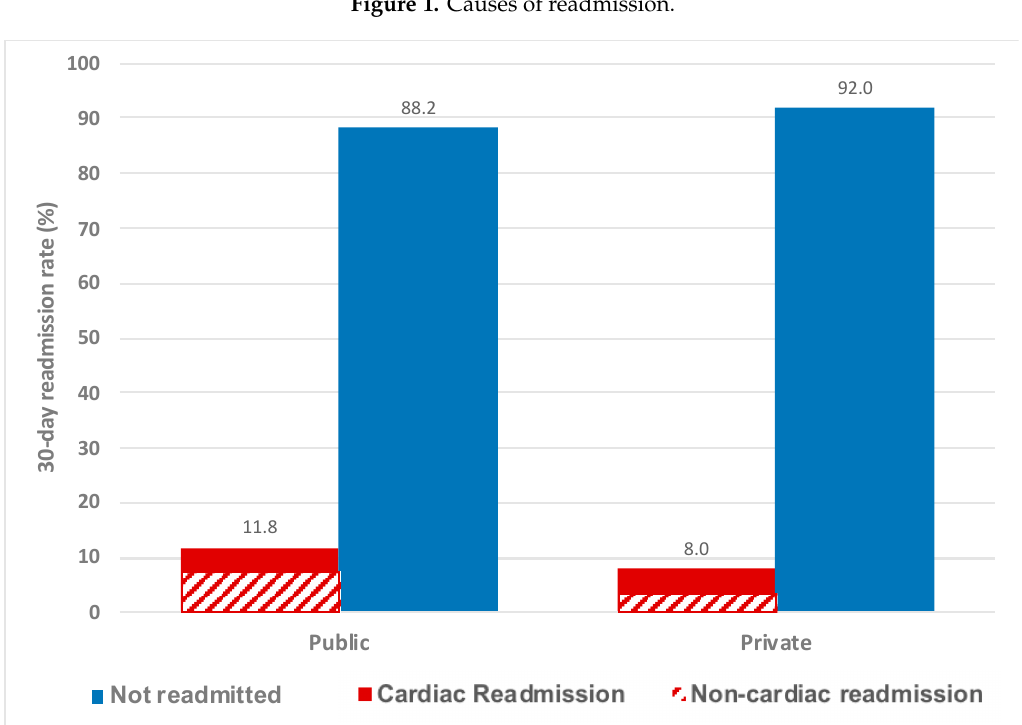
Figure 2. Comparison of readmission rates after PCI between public and private hospitals.